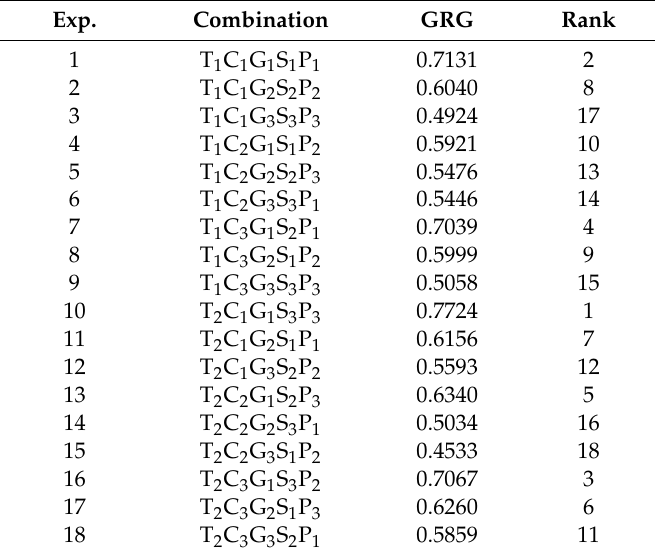
Table 6. Grey relational grade (GRG) and its rank. Exp. Combination GRG Rank